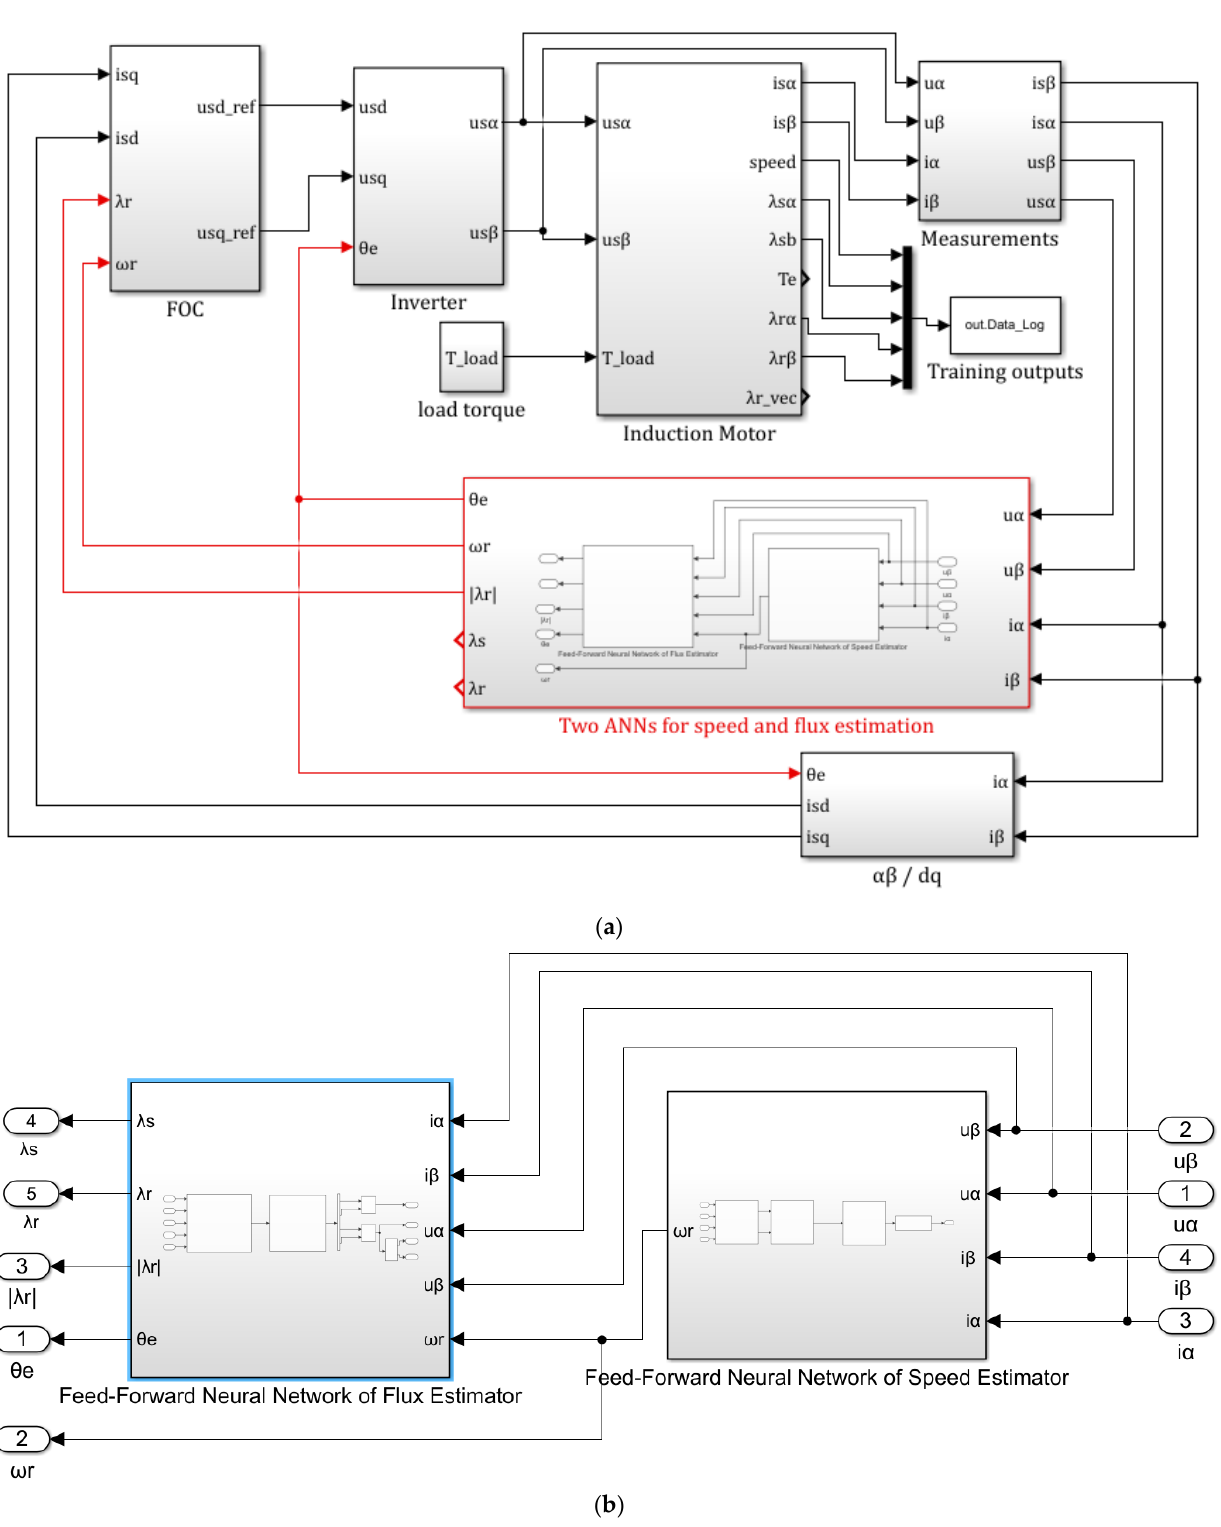
Figure 14. ( a ) The Simulink model of speed sensorless induction motor drives with ANN-based speed and flux estimators; ( b ) the Simulink model of the two ANN-based speed and flux estimators.